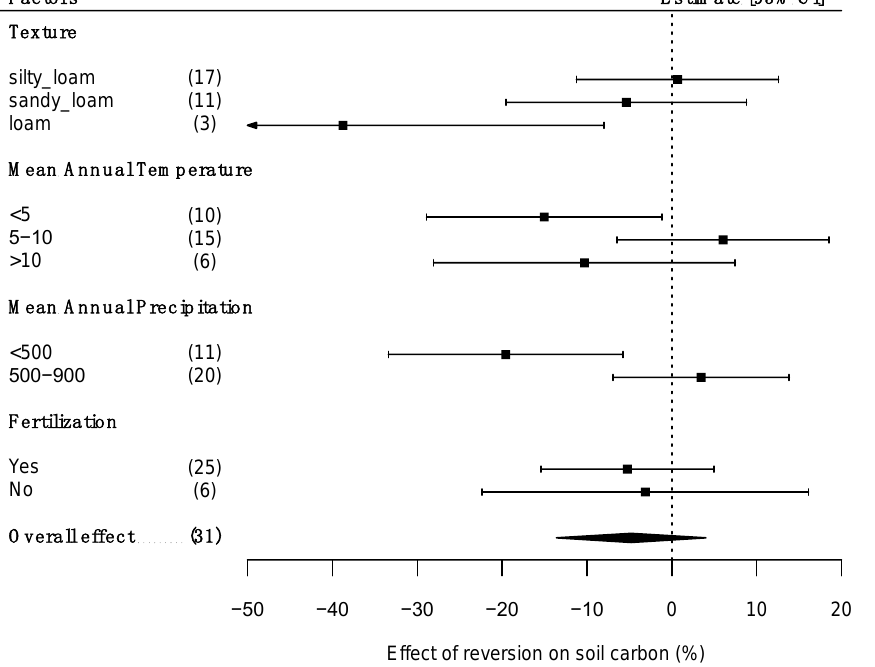
Figure 4. Percentage change of soil carbon (Mg C ha −1 ) after the reversion of perennial crops according to soil texture, mean annual temperature (°C), mean annual precipitation (mm), fertilization. Error bars represent the 95% confidence intervals. Parenthesis indicates the number of observations used to calculate the effect size.